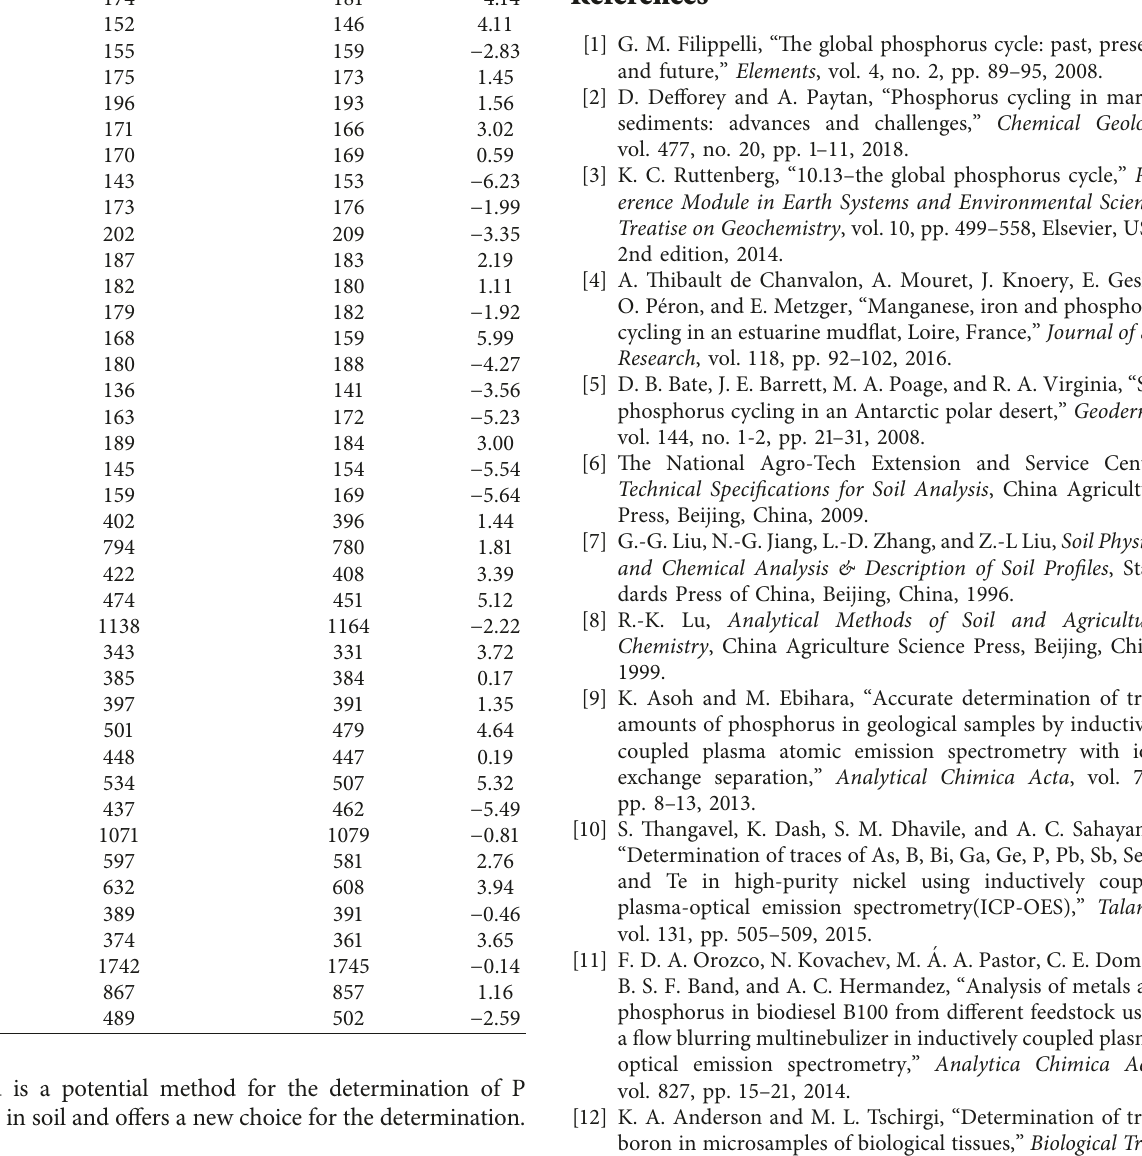
Table 9: Results of soil samples determined by ISAM and CCM. Content of P obtained Sample by ISAM